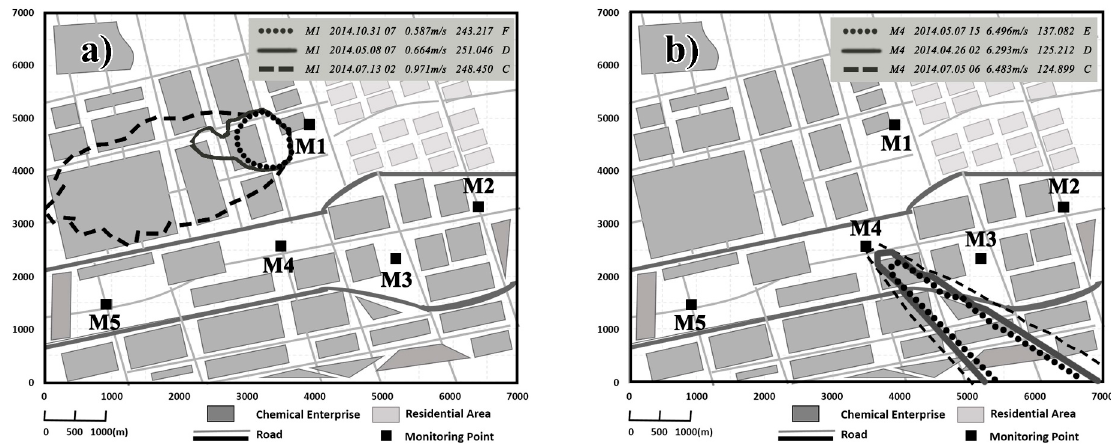
Figure 9. Source locations under different meteorological conditions: ( a ) typical source area results in low-wind-speed with different atmospheric stabilities; ( b ) typical source area results in high-wind-speed with different atmospheric stabilities.